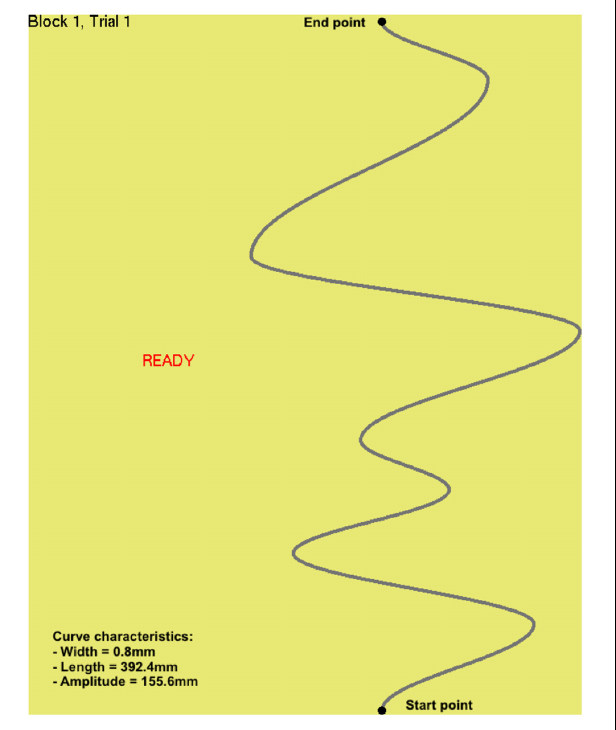
FIGURE 1 | Cropped and annotated screen-shot showing the target curve along with curve characteristics. This figure is an edited version of one previously published (Williams et al.,